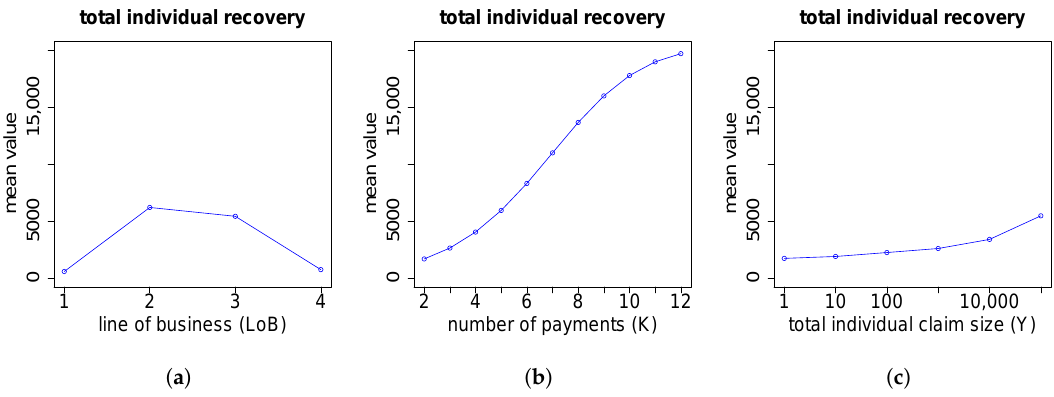
Figure A11. Total individual recovery Y − w.r.t. the features ( a ) LoB ; ( b ) number of payments K and ( c ) total individual claim size Y